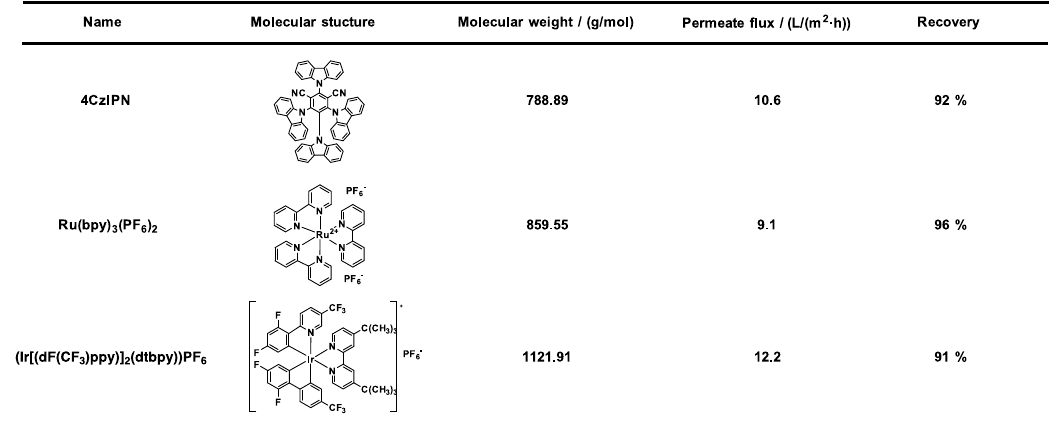
amination executed with in-line TBADT recovery. The equilibration phase of the experiment is reported with a shaded background. c Preliminary investigations of the recovery of other commercially available photocatalysts with nano fi ltration. For more experimental details see Supplementary